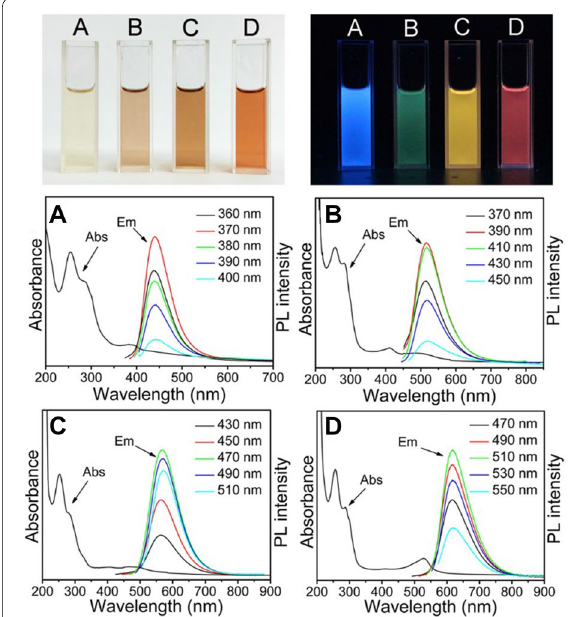
Fig. 5 Top images are photographs of CQDs samples A – D in aqueous solution under daylight (left) and UV light (right). The bottom four graphs show their absorption curves and their PL emission spectra under excitation with light of different